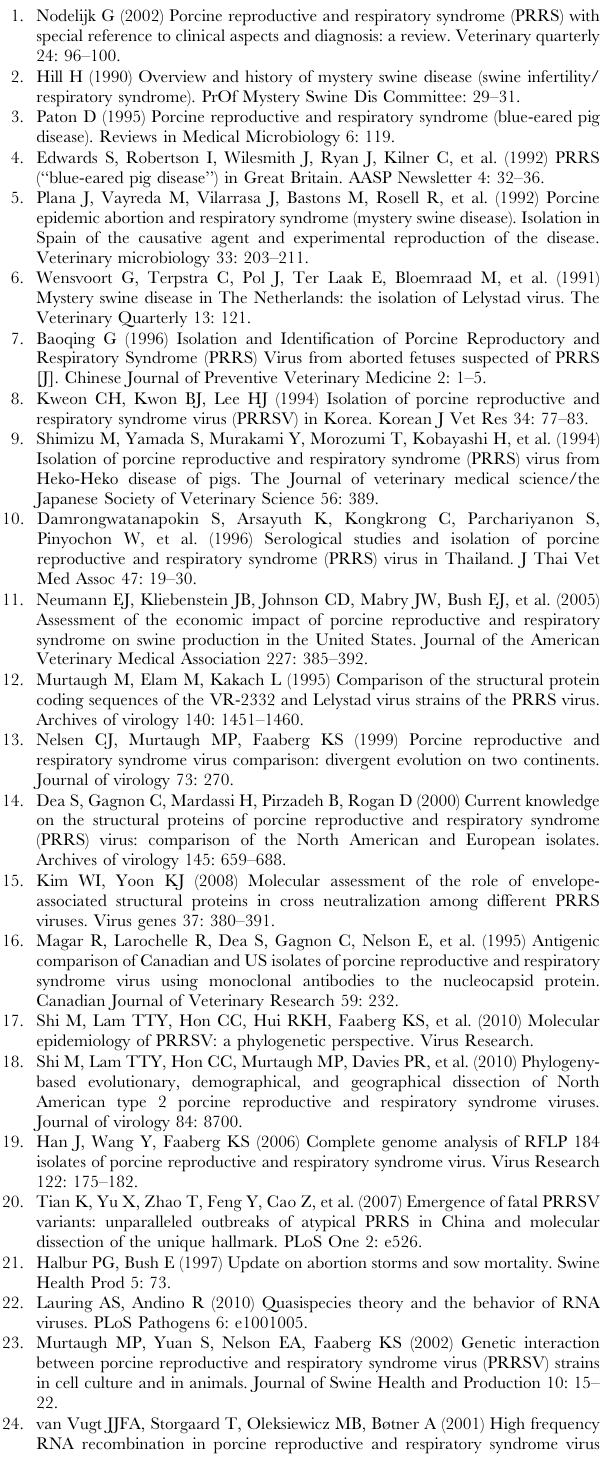
Table S1 Primers used in generating overlapping amplicons spanning PRRSV genomes. Table S2 Details of recombinational events detected in HK PRRSV